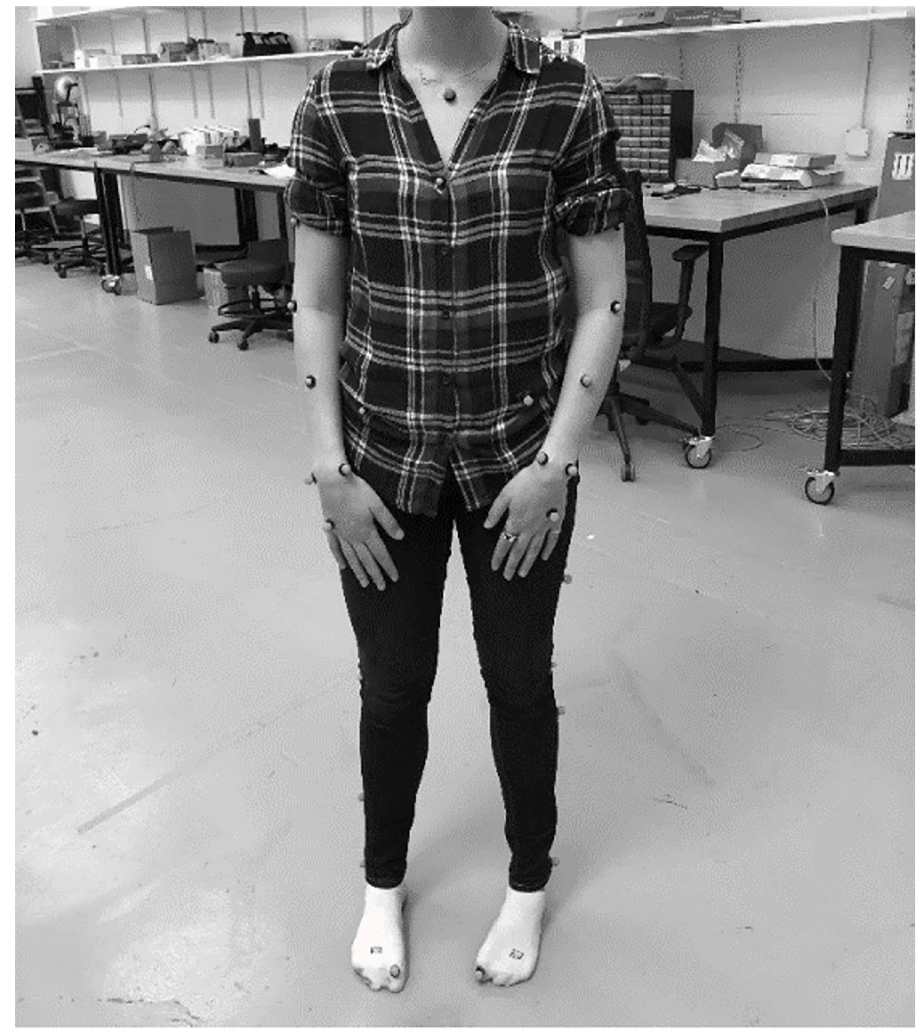
Fig 1. Depiction of subject with reflective markers of the Vicon system placed on lower and upper body. Note . Reflective markers from the lower body were utilized for the current